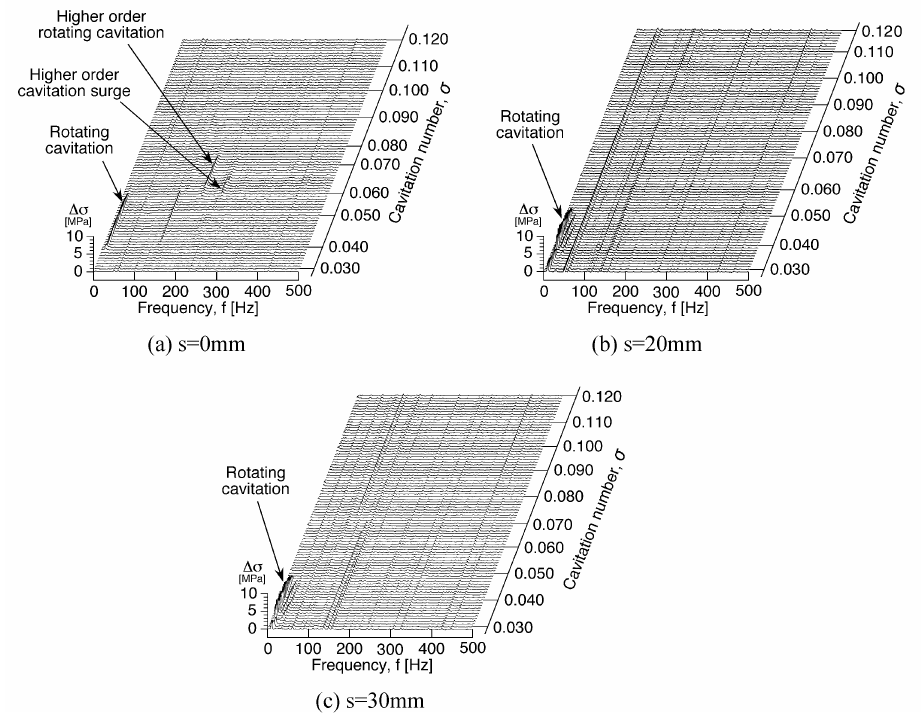
Spectra of blade stress fluctuation in the cases of s =0mm, 20mm, and 30mm, for 3000rpm, φ